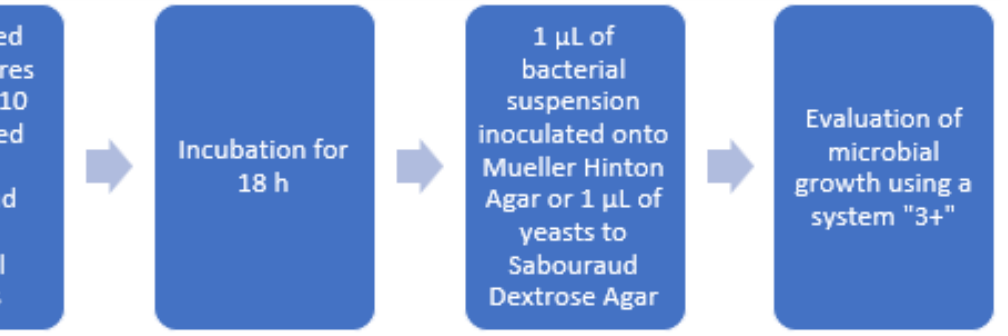
Figure 3. Preparation of microbes for evaluation after indirect contact with CuO nanoparticles.